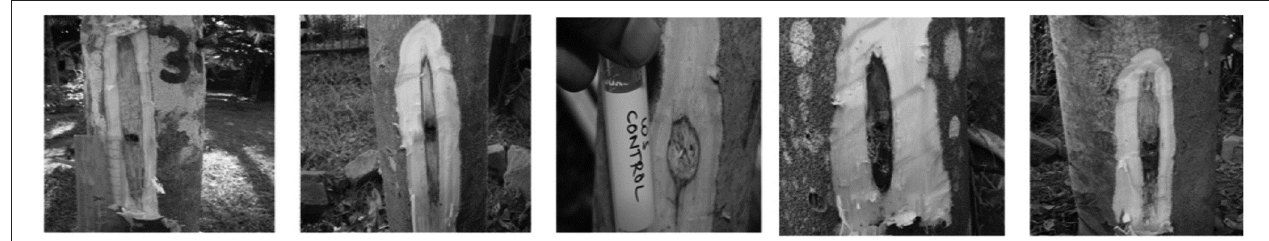
FIGURE 6 | Artificial infection in different Aquilaria malaccensis trees after 3 months of inoculation of fungal and bacterial strain: Dark brownish color of wood showing the initiation of artificial infection.